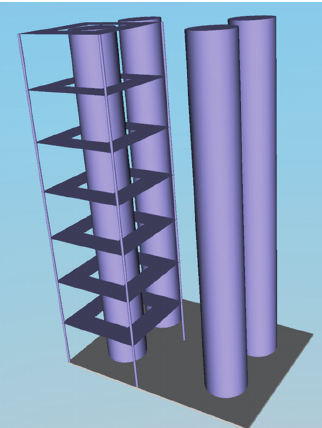
Figure 3: View of four ECCS PTs 3D computer